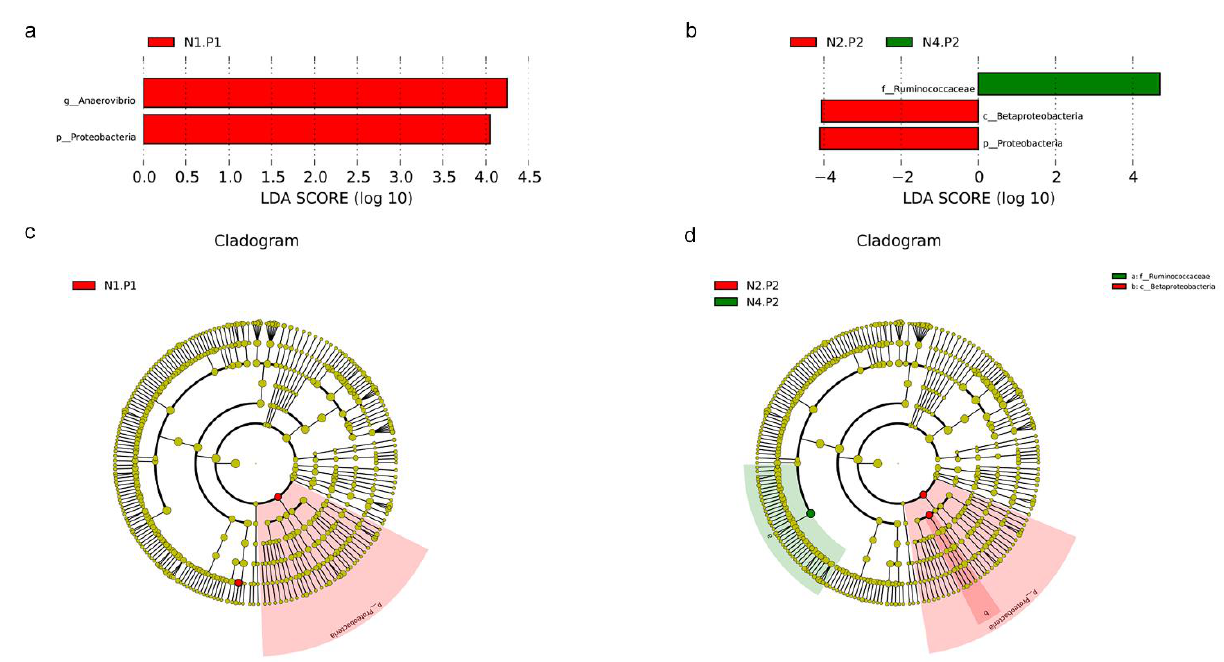
Figure 7. LEfSe analysis. ( a ), histogram of the results of LEfSe among four groups in P1 stage and their respective effect sizes, p < 0.05 considered significant; ( b ), histogram of the results of LEfSe among four groups in P2 stage and their respective effect sizes, p < 0.05 considered significant; ( c ), cladogram showing taxonomic representation of differences among four groups in P1 stage; ( d ), cladogram showing taxonomic representation of differences among four groups in P2 stage. P1: the experimental period is 7 days. P2: the experimental period is 14 days. N1: 22.5 mg/kg niacin group. N2: 30 mg/kg niacin group. N3: 45 mg/kg niacin group. N4: 75 mg/kg niacin group. Table 7. The concentration of colon contents in weaned piglets with different niacin concentrations 1 .